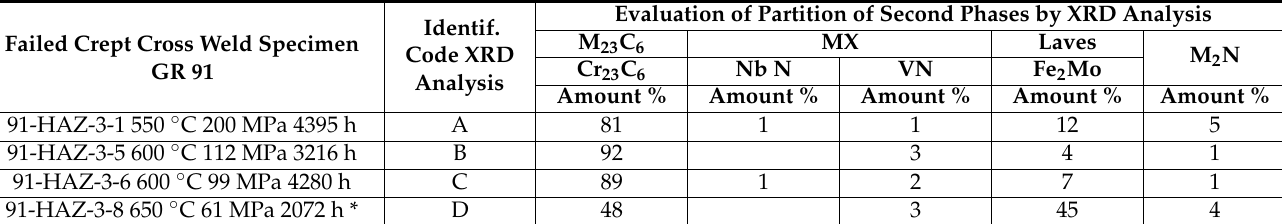
Table 11. Evaluation of precipitated phases in steel Grade 91 samples by XRD.